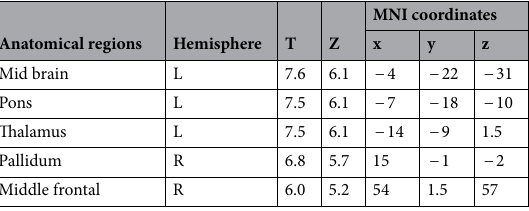
Table 2. Grey matter differences between Pandits/Priests and control based on VBM analysis (Pandit > control).